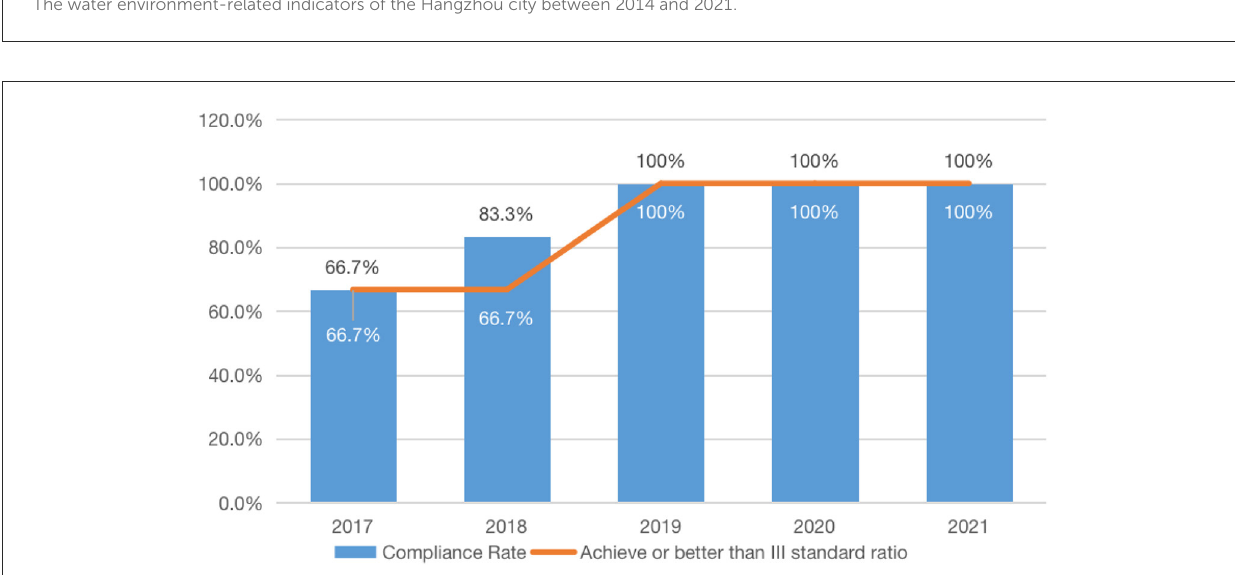
FIGURE3 The water environment-related indicators of the Hangzhou city between 2014 and 2021.